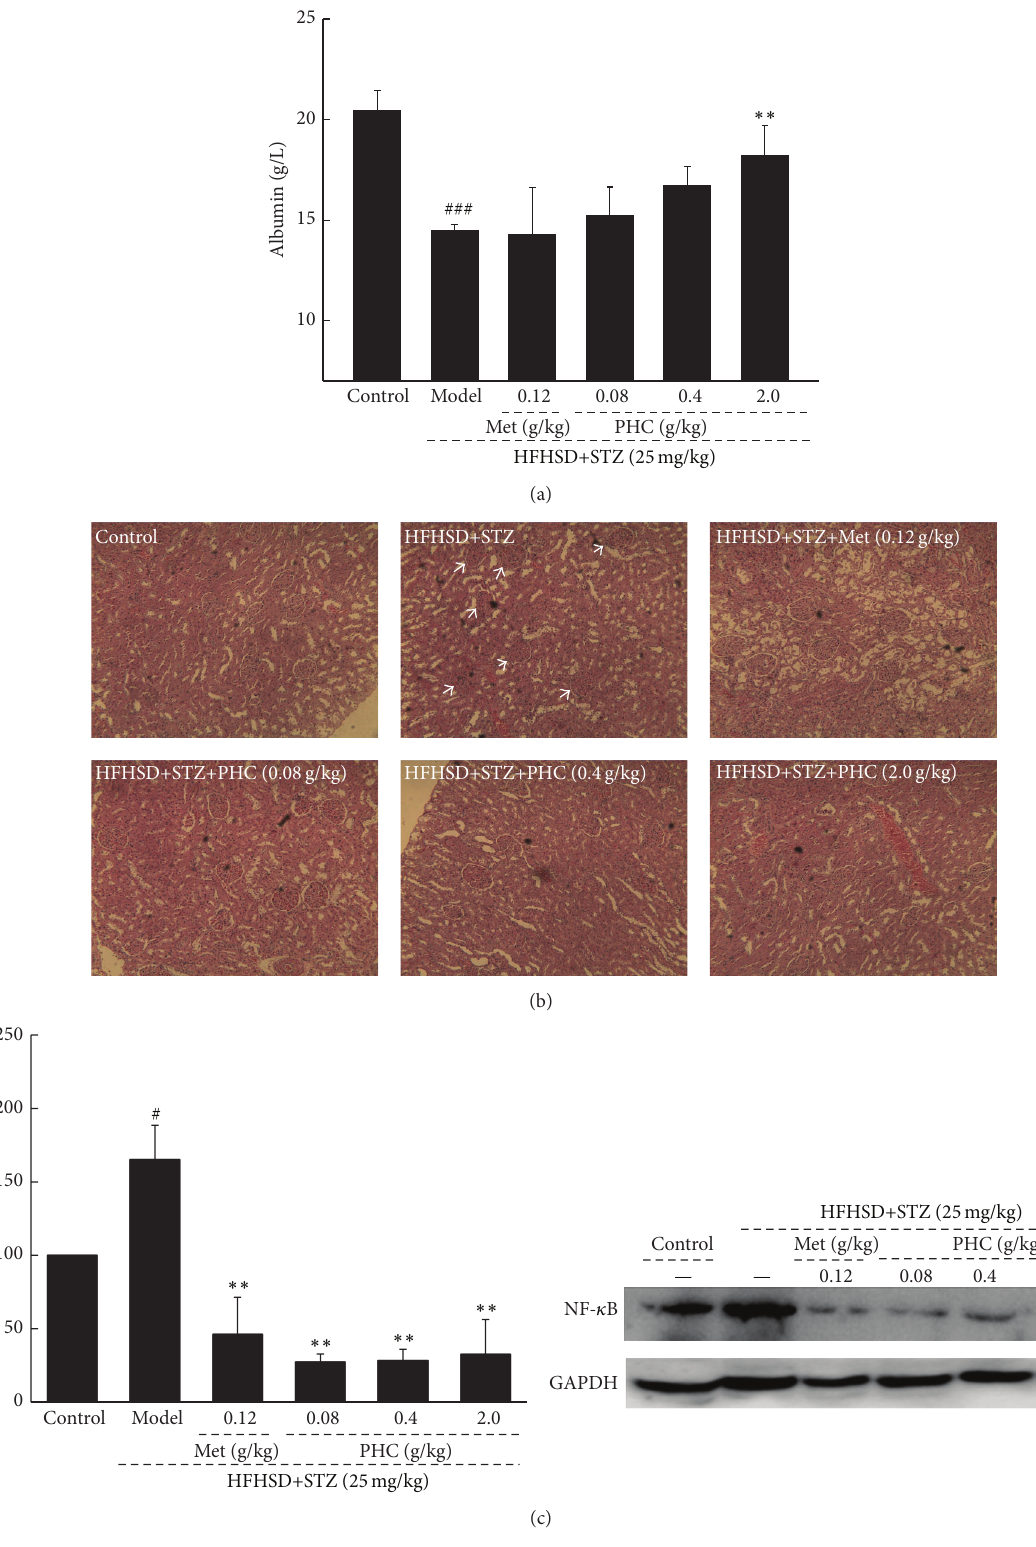
Figure 5: Diet-STZ-induced diabetic rats were orally treated with or without Met and PHC for four weeks. (a) PHC enhanced the low serum level of albumin. (b) Histopathological analyses in kidney were applied via H&E staining ( × 100). (c) The expression of NF- 𝜅 B in kidney was analyzed via western blot. Quantification data of the expressions of NF- 𝜅 B was normalized by corresponding GAPDH. Data are expressed as mean ± SD ( 𝑛 = 10 ) and analyzed by using one-way ANOVA. # 𝑃 < 0.05 and ### 𝑃 < 0.001 versus control, ∗∗ 𝑃 < 0.01 versus model